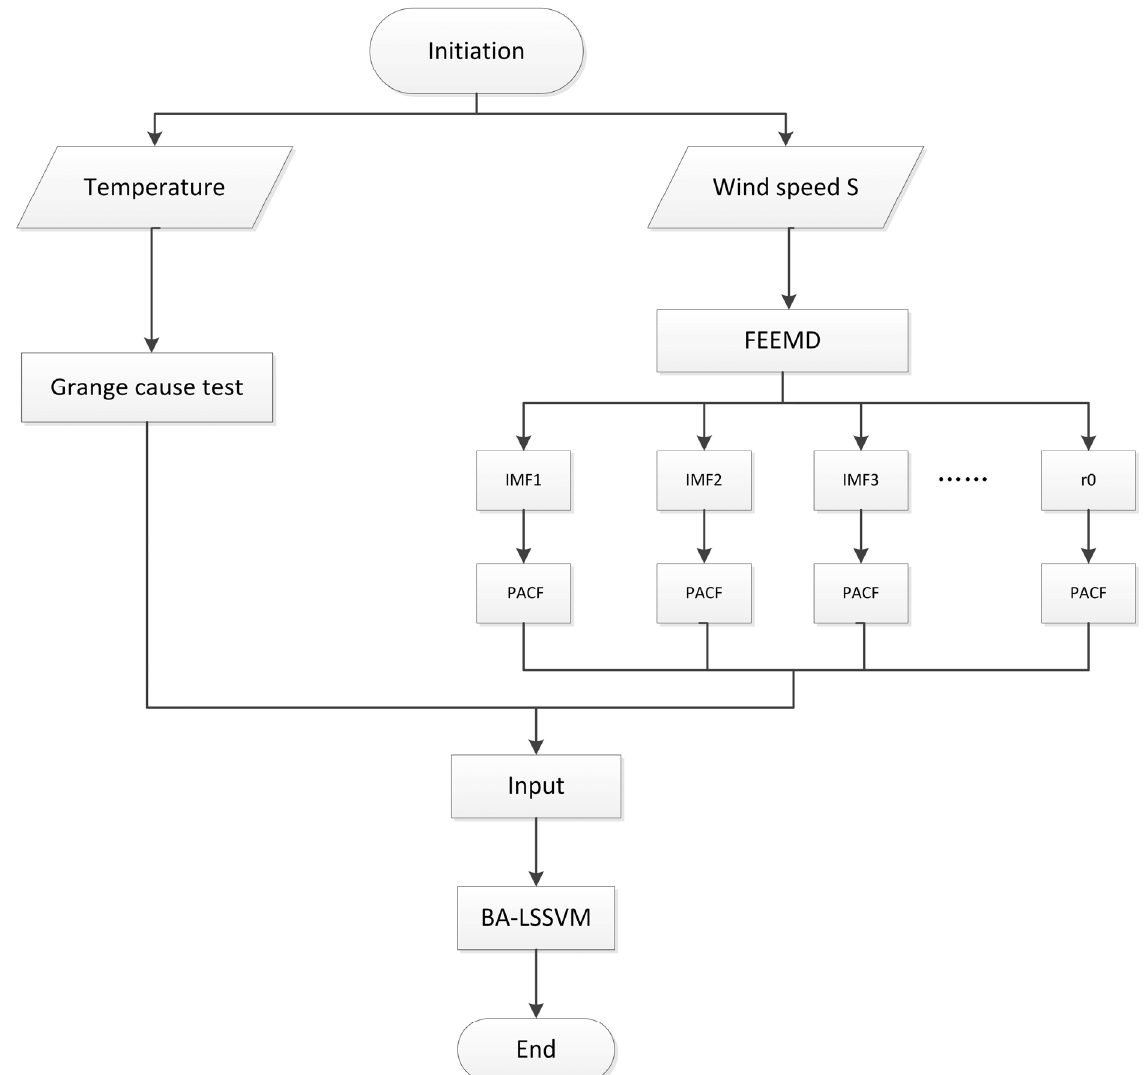
Figure 2. The overall flowchart of